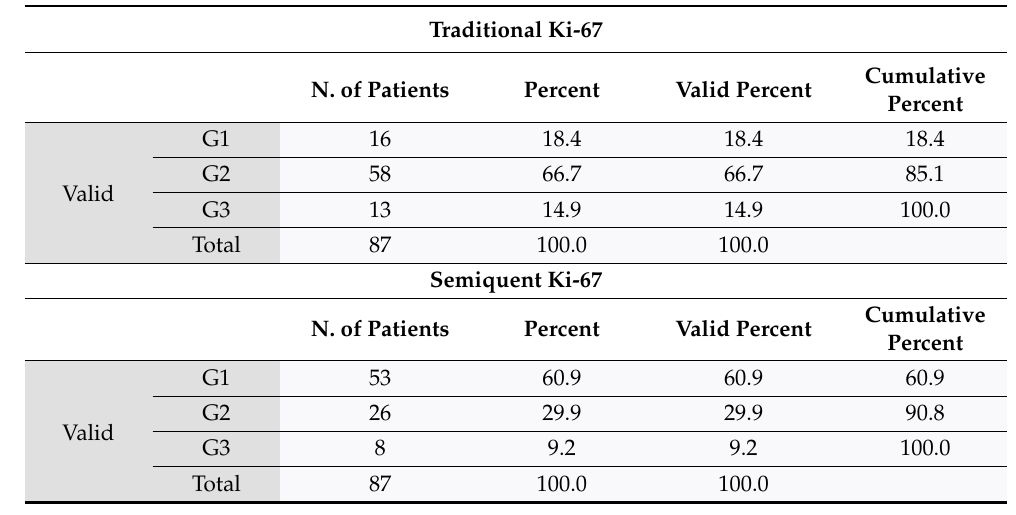
Table 4. Difference in the classification of patients (G1, G2, G3) using the proposed new